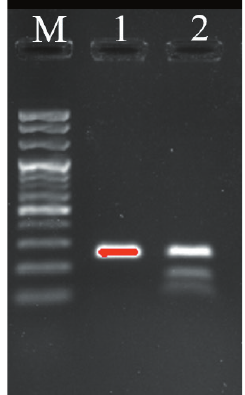
Figure 1. Agarose gel electrophoresis of alcohol dehydrogenase 1C (ADH1C) gene c.-64T>C polymerase chain reaction-restriction fragment length polymorphism.